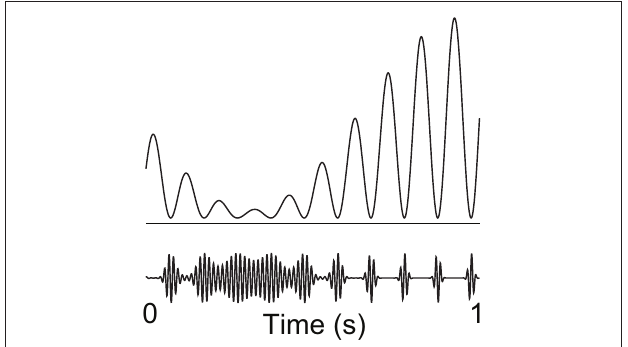
Figure 4 | We hypothesize that alpha activity serves to functionally disengage a given region by means of “pulsed inhibition.” Consider the ongoing gamma rhythm in the lower trace which reflects neuronal processing. The pulsed alpha inhibition temporarily silences the gamma activity. As alpha goes stronger, the “duty-cycle” of gamma and thus neuronal computation decreases gradually. Reproduced from Osipova et al.